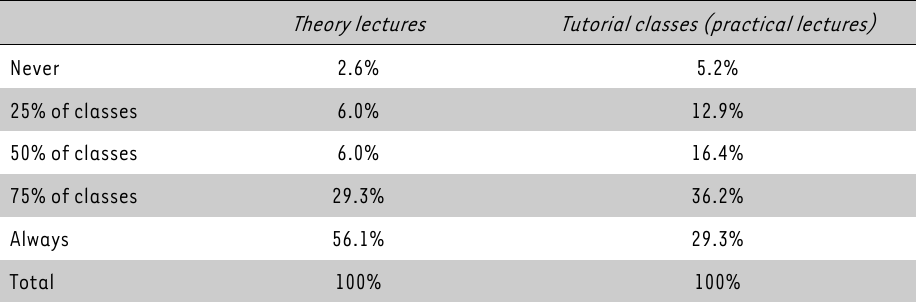
Class attendance – theory and practical lectures Theory lectures Tutorial classes (practical